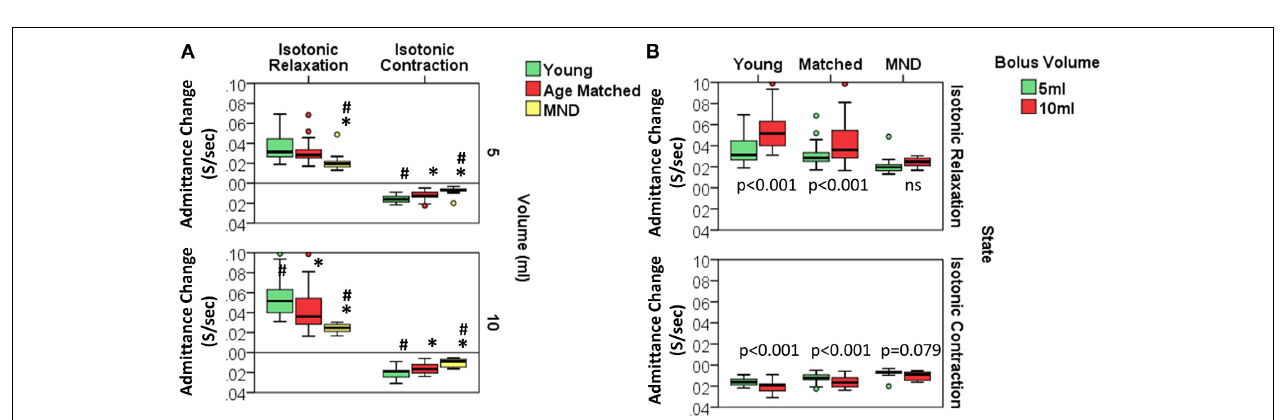
(B) Temporal profles of the five mechanical states in panel A as determined for 5ml swallows. These are numbered in order from 1 to 5 (A) . (i & ii) indicate the timepoints of increased activity consistent with swallow onset and luminal opening respectively. Note this suggests that Isometric activity increase is both diminished and delayed.